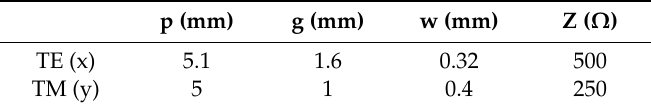
Table 1. Geometrical dimensions of sector A for each